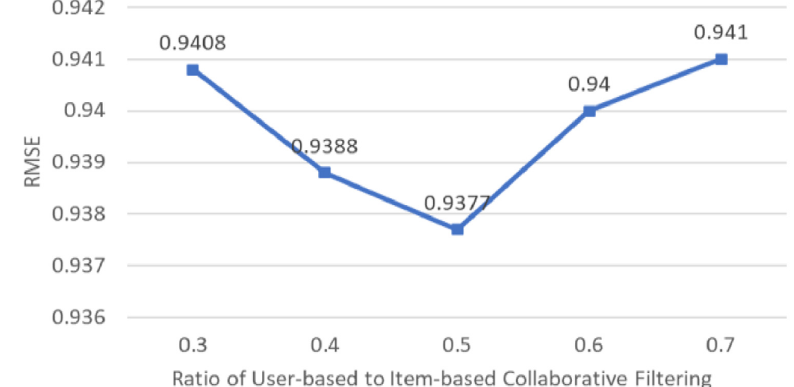
Figure 3. RMSE of Various Ratios of User-based to Item-based Collaborative